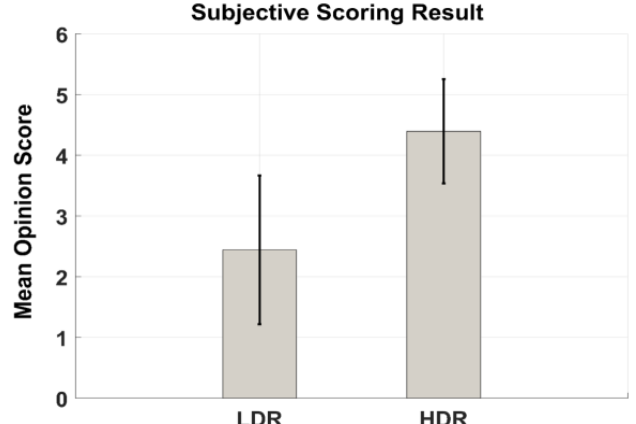
Figure 2. Comparison of the subjective scores for LDR and HDR images. HDR images received significantly higher scores than LDR images.